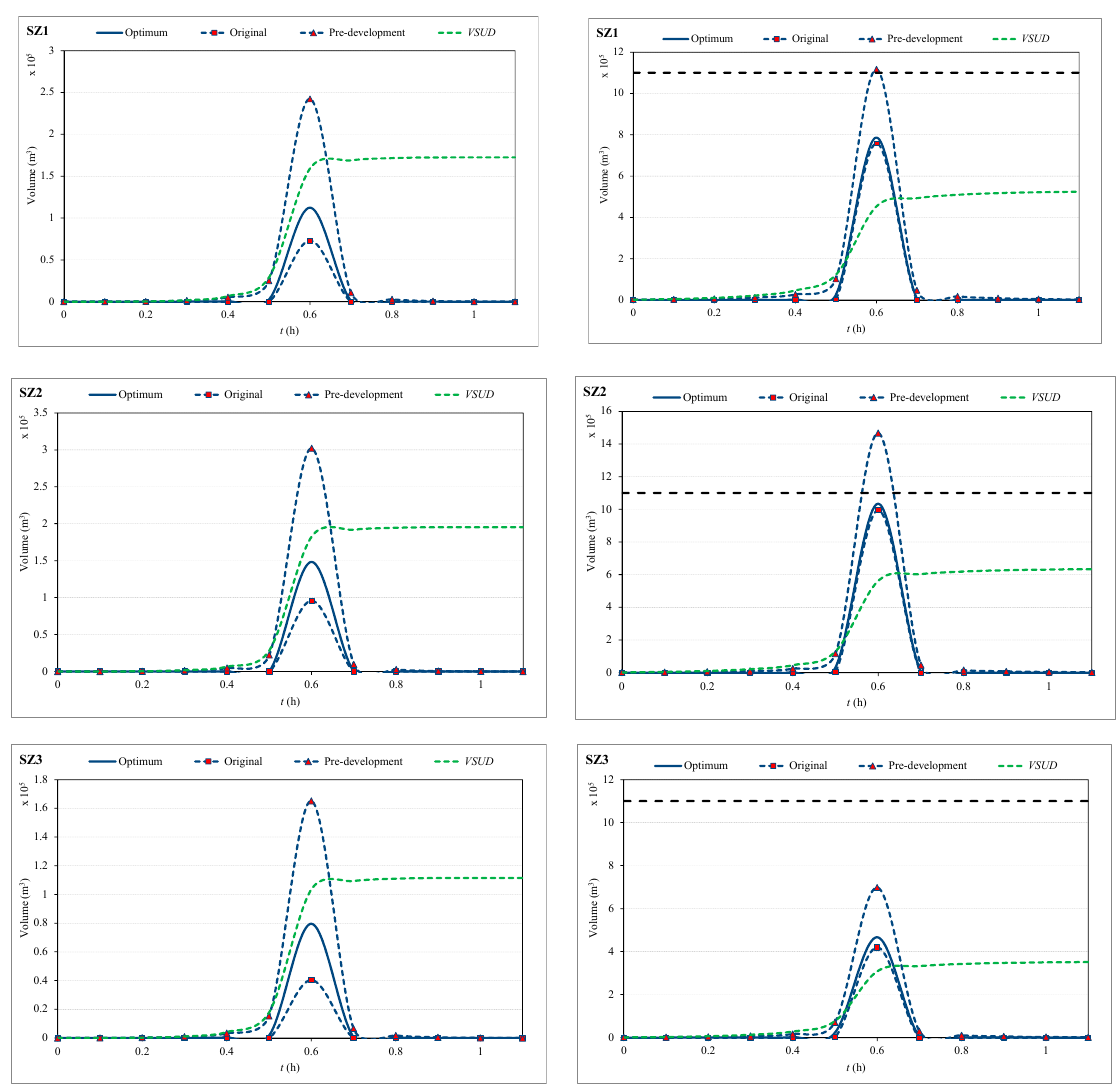
Figure 6. CUD and VSUD level for 5 ( left column ) and 100 ( right column ) years return period, 1.1 h duration, storm events.